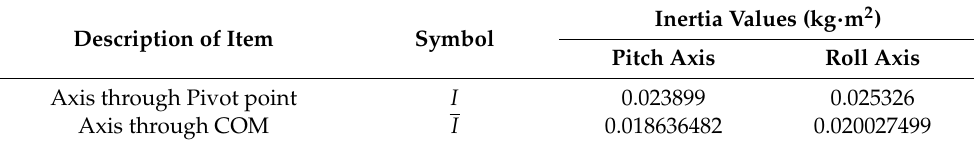
Table 4. Results from experimentation used to determine the moments of inertia.